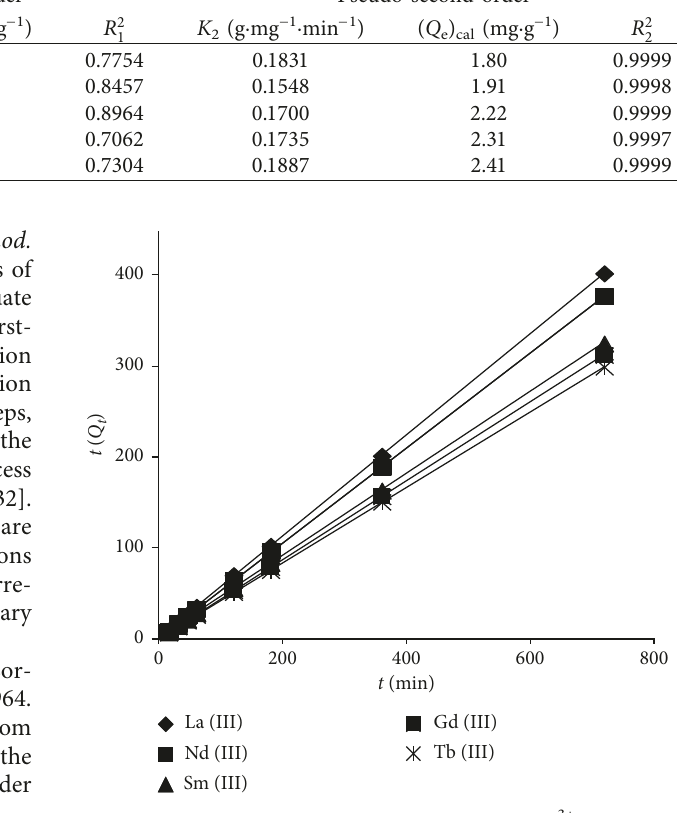
Figure 3: Pseudo-second-order kinetic plot for Ln 3+ sorption.